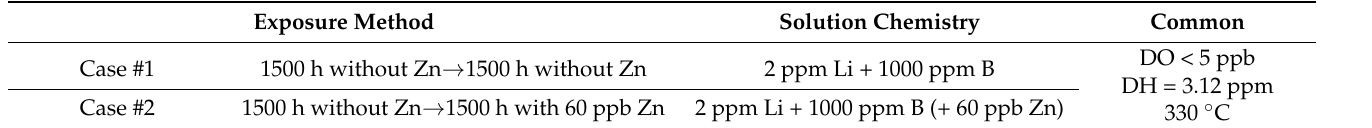
Figure 1. Optical images and dimensions of specimens for ( a ) corrosion measurements and ( b ) oxide analyses. Table 2. Main experimental conditions for the corrosion tests.